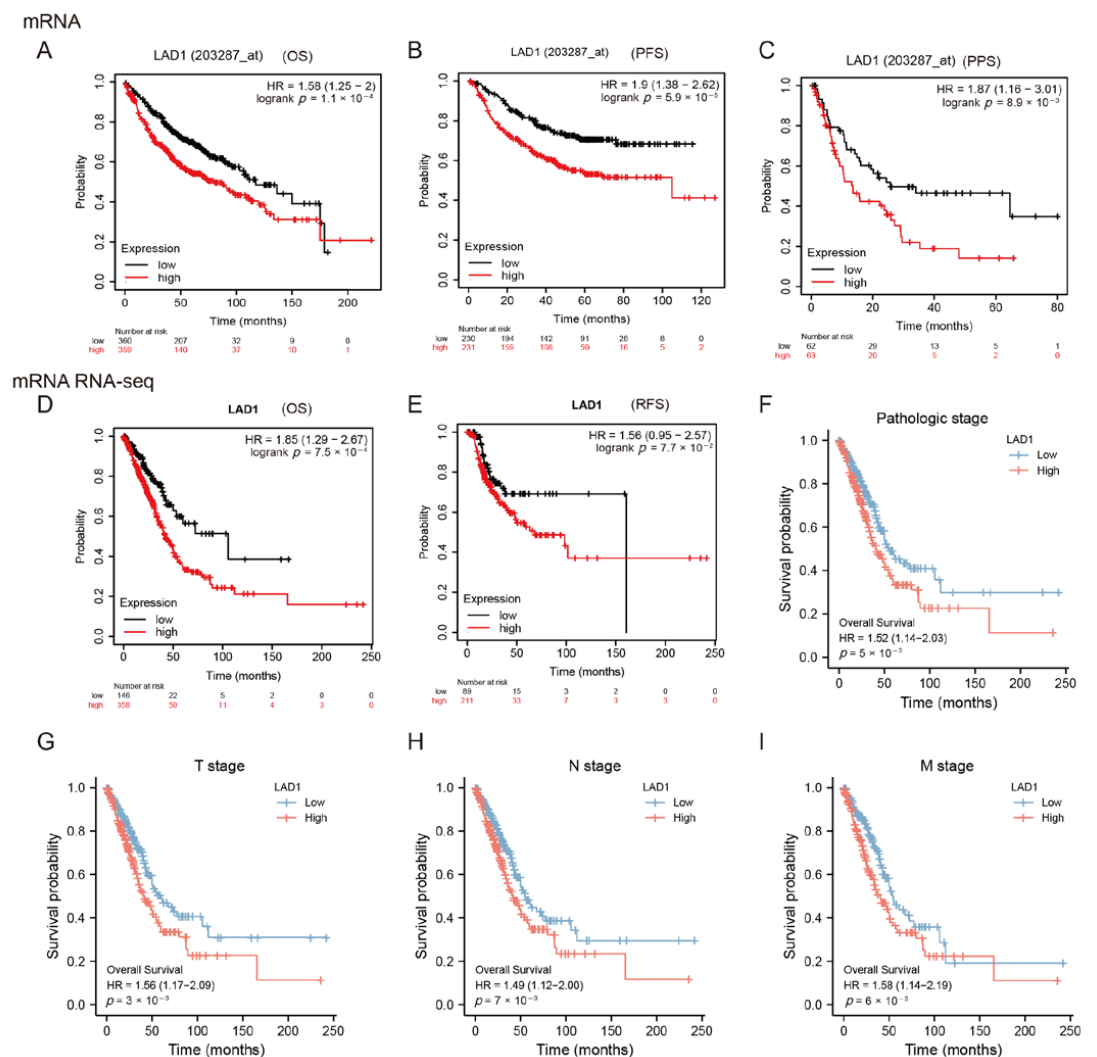
Figure 2. The upregulation of LAD1 in LUAD predicts poor prognosis. Kaplan–Meier analysis was performed based on gene chip data to compare the survival probability between high and low LAD1 expression groups, including overall survival ( A ), progression-free survival ( B ), and post-progression survival ( C ). ( D ) Kaplan–Meier curves based on mRNA RNA-seq data for overall survival analysis and relapse-free survival ( E ). ( F – I ) Subgroup analyses of overall survival based on high and low LAD1 expression, including pathologic stage ( F ), T stage ( G ), N stage ( H ), and M stage ( I ).